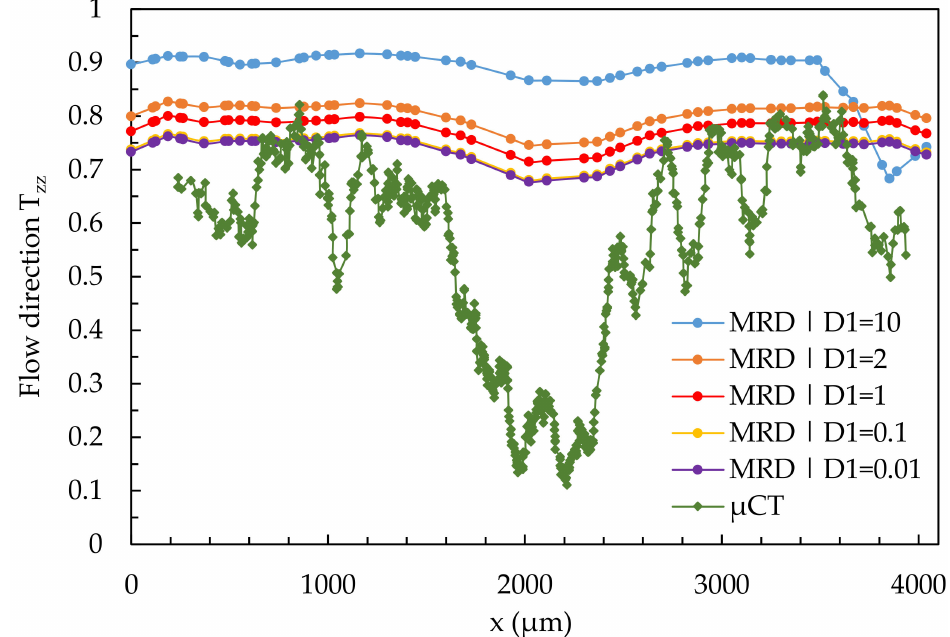
Figure 18. Quantitative results of fiber orientation in T zz -direction over the cross-section characterized by µ CT and predicted by the 3D mesh under variation of the parameter D 1 at location